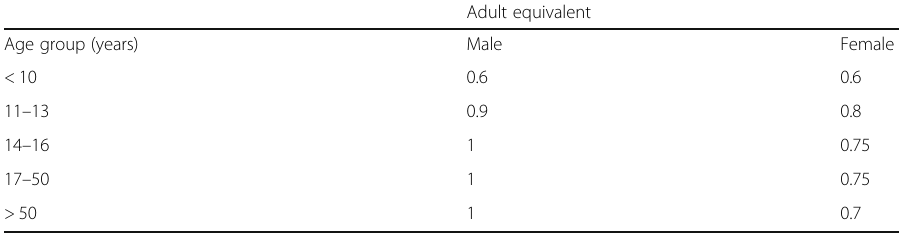
Adult equivalent